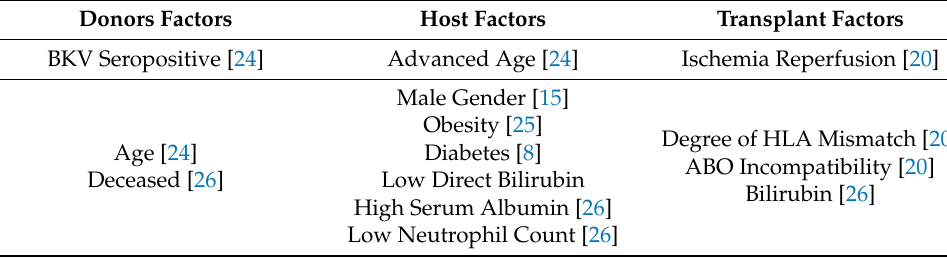
Table 1. Principal Risk Factors for the onset of